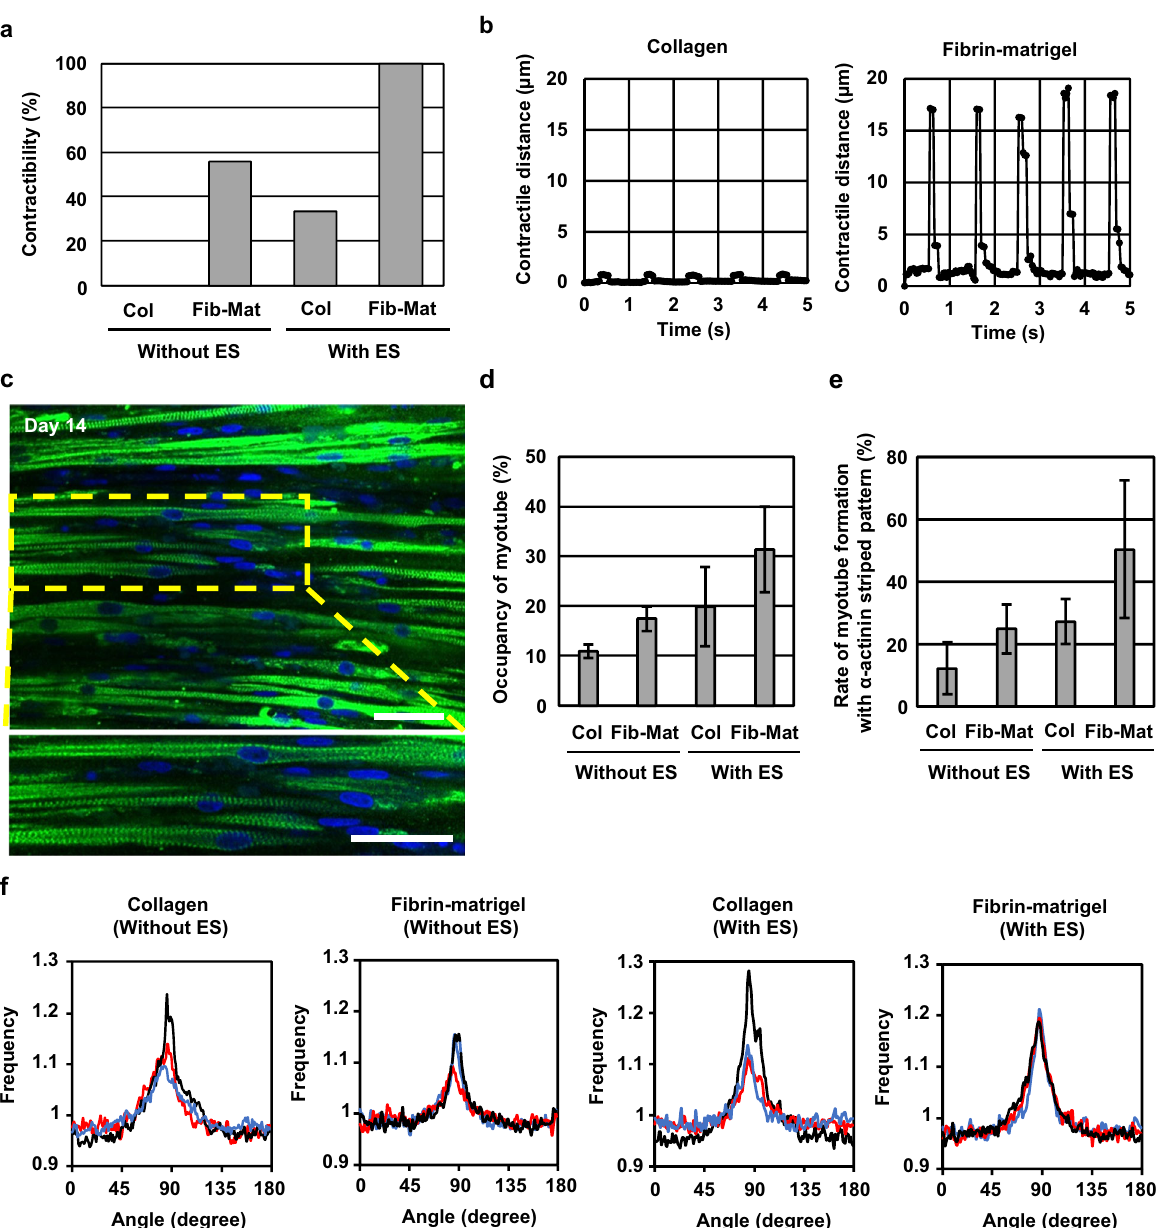
Fig. 2 Morphological and functional analysis of bovine muscle tissue. a Rate of fi bre-shaped bovine muscle tissues capable of contracting in response to applied electrical stimulation (the number of contractile tissue/the number of all tissues), formed with the collagen (Col)-based tissues cultured with and without electrical stimulation (ES) (amplitude: 3 V/mm, frequency: 1 Hz, duration: 2 ms) ( N = 6), and the fi brin- matrigel (Fib-Mat)-based tissues cultured with and without ES ( N = 9). b Temporal variation of contractile distance of the fi bre-shaped bovine muscle tissue formed with collagen and Fib-Mat depending on the ES. c Confocal images of the bovine muscle tissue; cell nucleus (blue), α - actinin (green). d Occupancy of myotubes in the short-axial cross-section of the muscle tissue under different culture conditions ( n = 3). e Rate of myotube formation with α -actinin striped patterns in all myotubes in the muscle tissue. ( n = 3) f Directional distribution of brightness calculated from FFT images corresponding to confocal images. 0 degree and 180 degree show short-axial direction of the tissue and 90 degree shows its long-axial direction. Black, red and blue lines in each plot represent values for different tissues. All error bars show standard deviation. Scale bar, ( c ) 50 μ